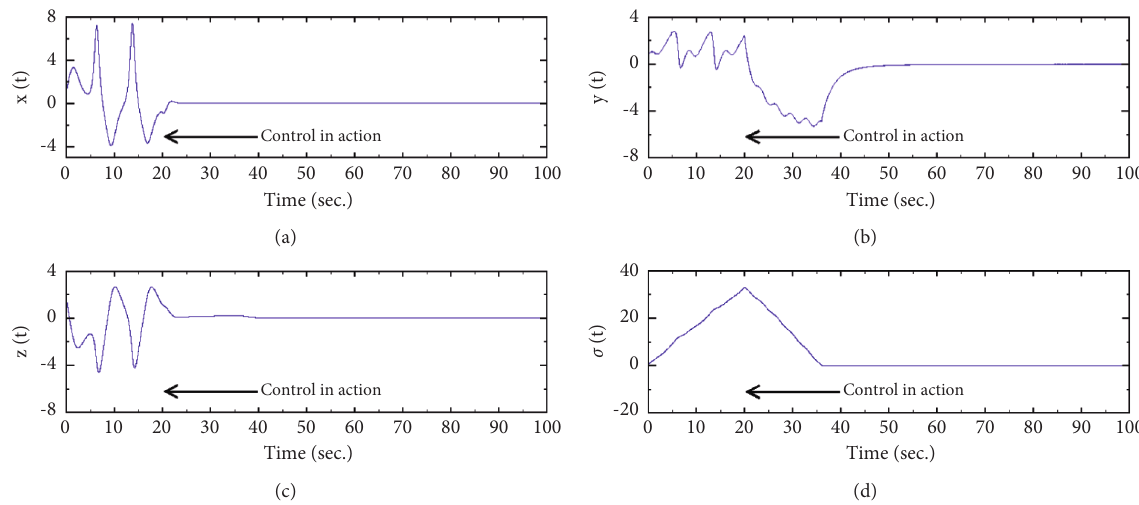
Figure 13: The time series of the controlled incommensurate fractional-order system state variables and corresponding time series of the sliding surface with uncertainty and external disturbance (the control input is activated at t � 20